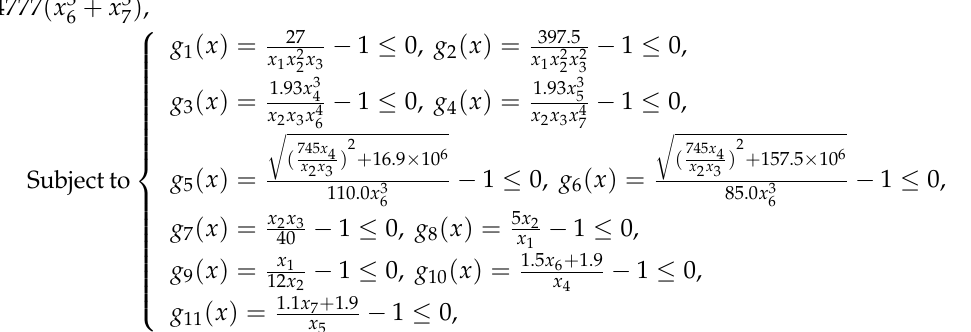
Table 8. Statistical results of the tension spring design